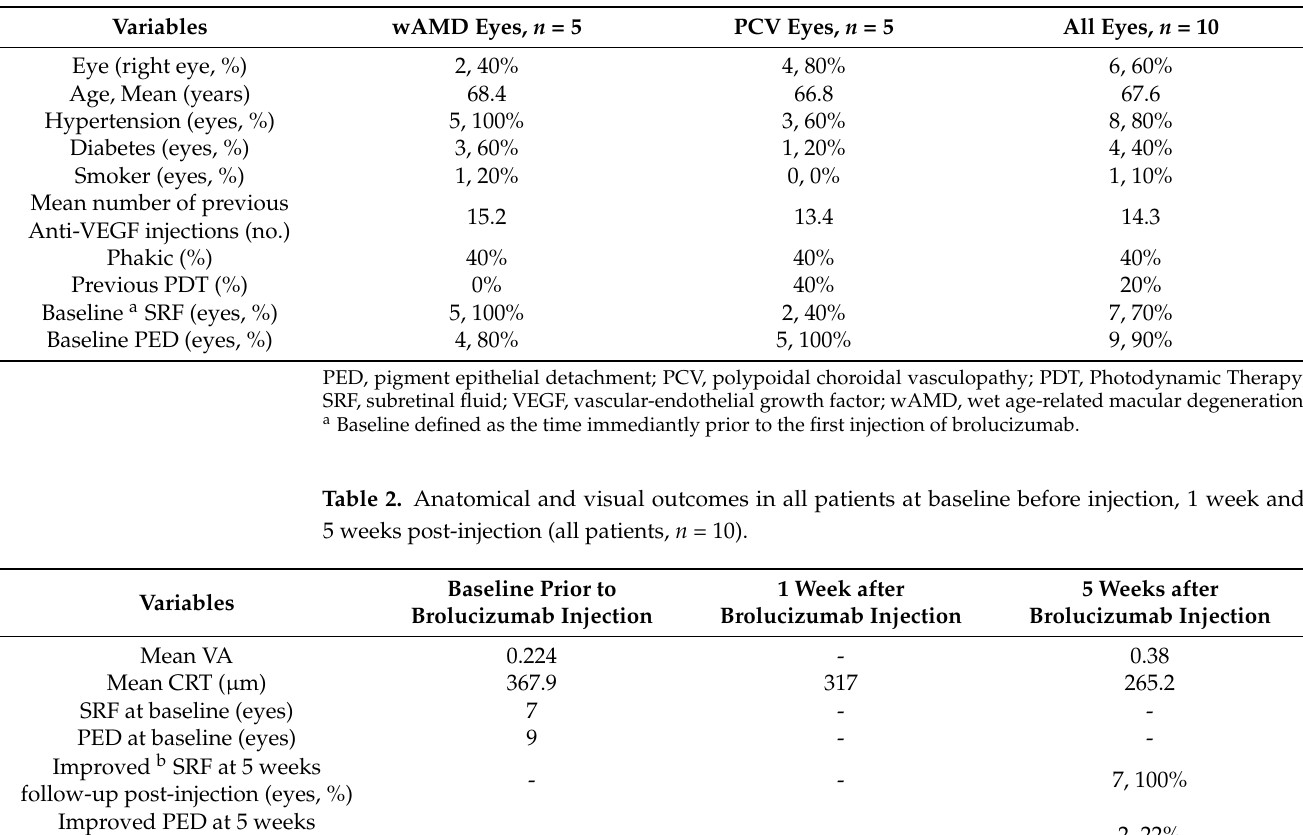
Table 1. Baseline characteristics of all patients ( n = 10).